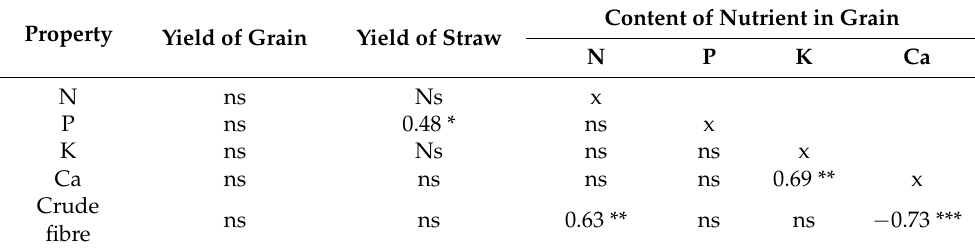
Table 10. Simple correlation coefficients between yield and nutrient content in grain of spring barley in experimental period (2009 to 2011) ( n =